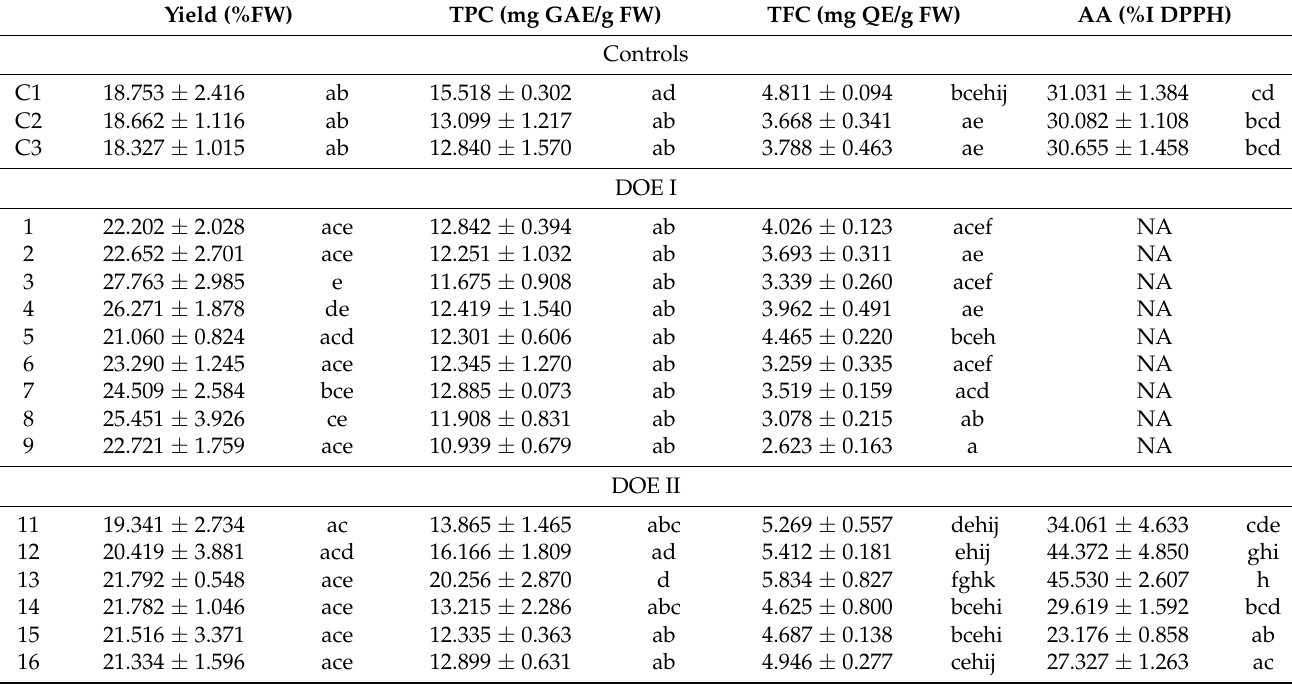
Table A4. The extraction yields, total phenolic content (TPC), total flavonoid content (TFC), and free-radical scavenging capacity (AA) in response to the different enzymatic digestion treatments applied in the three designs of the experiment (DOE I, II, and